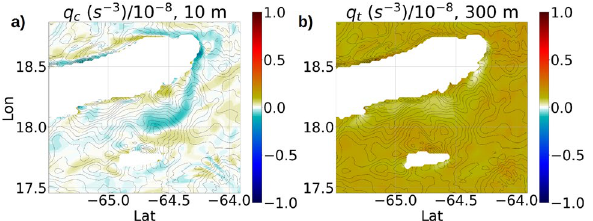
Figure 16. Snapshots at −300 m depth showing ( a ) instantaneous baroclinic component ( q c ) of the potential vorticity at yearday 273, 00:00 AM; ( b ) barotropic component ( q t ) at the same time. Expressions for the baroclinic and barotropic components of q are shown in Online Appendix 10.